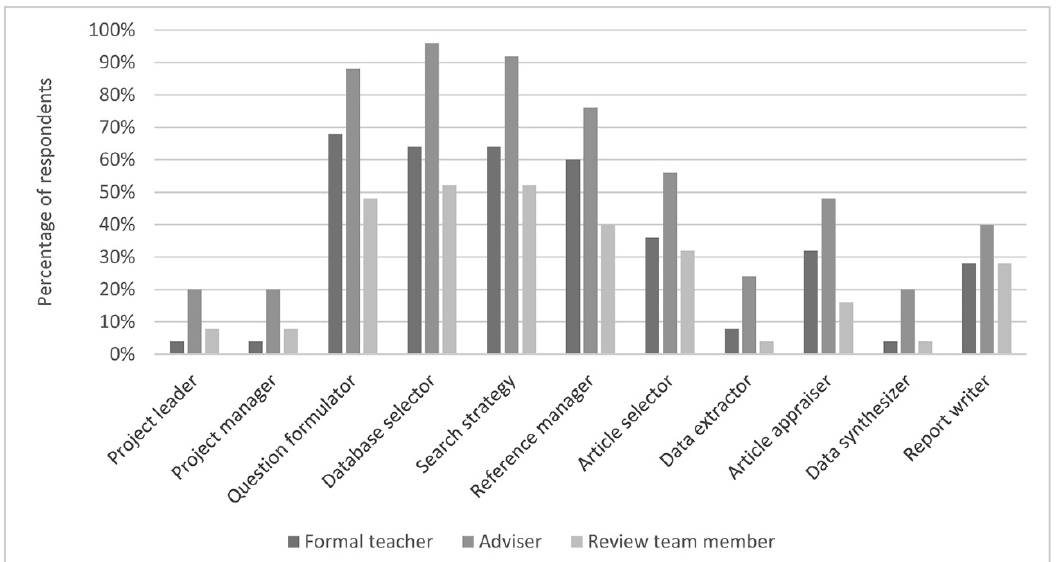
Figure 1 Veterinary librarian roles in systematic and scoping